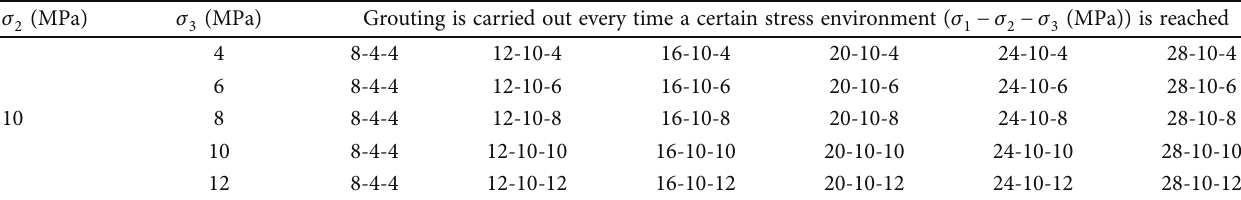
Figure 6: Three-dimensional reconstruction of a single fracture and its fractal dimension. Table 1: Three dimensional stress values of the grouting